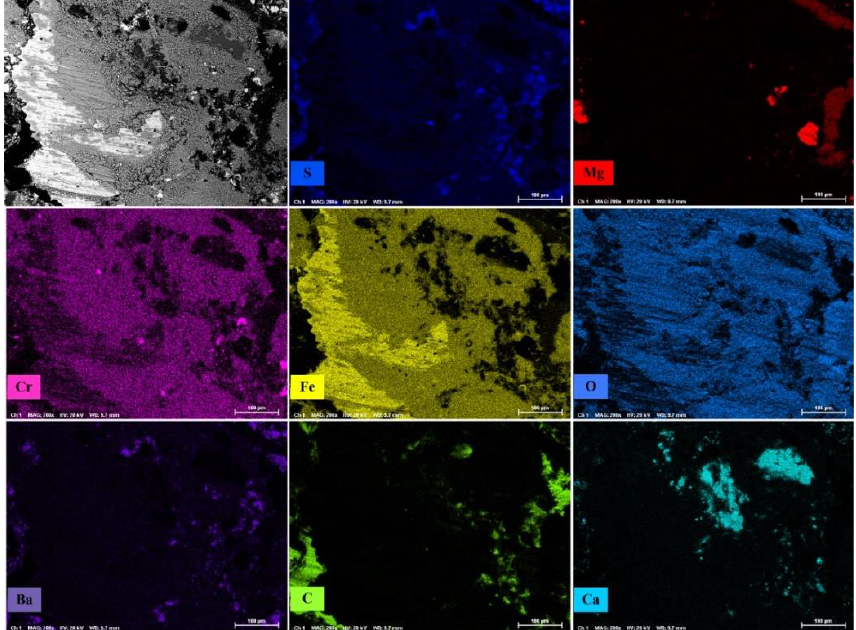
Figure 8. SEM of the pin and counterpart F55 + AISI415-coated disc: ( a ) coating surface and ( b ) pin A; ( c ) coating surface and ( d ) pin B. Numbers 1, 2, 3, 4 placed on secondary plateaus where EDXS analyses were carried out (results in Table 5).